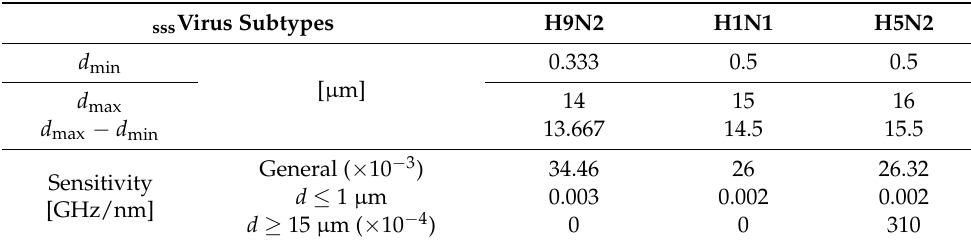
Table 4. Numerical representation of sensitivity parameters around the first peak for CrossPMA. Minimal absorption is declared at 50% of the absorption value of the unloaded